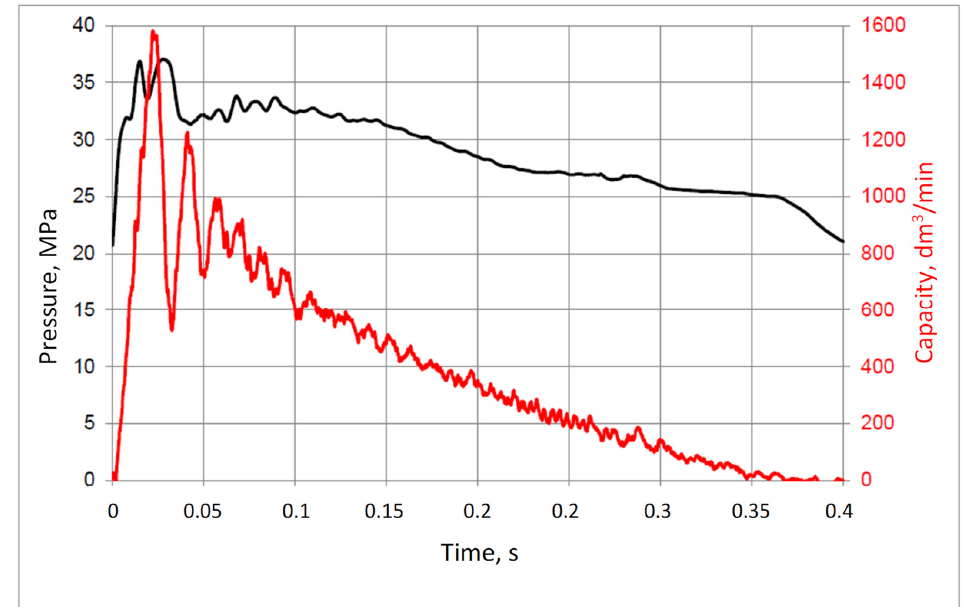
Figure 7. Flow characteristics of the tested valve as a function of time.